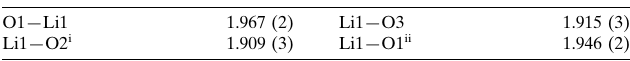
Selected bond lengths (A˚ ).